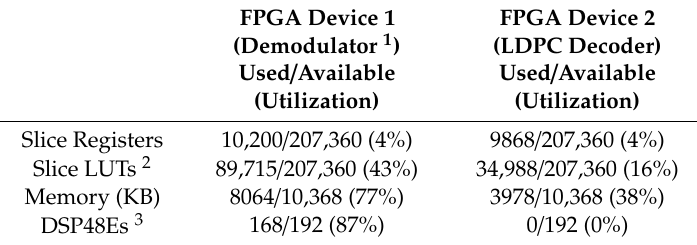
Table 4. Comparison of resource utilization in DVB-T2, DVB-C2, DVB-S2, and DVB-X2